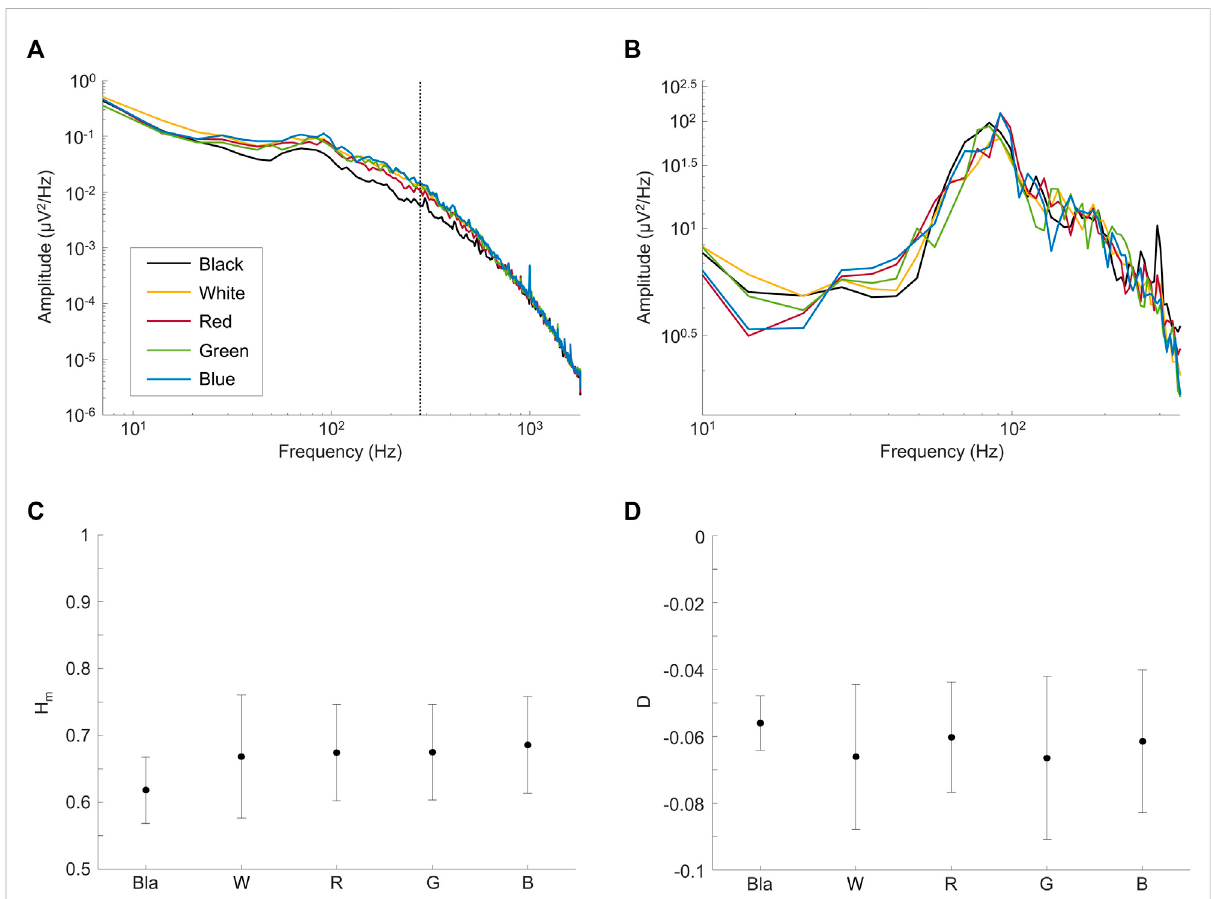
FIGURE 3 Comparing rsERGs at background light colors. Mean frequency spectrums of rsERGs obtained from different colored background lights at 30 cd m − 2 , i.e., black (no illumination; black tracings), white (yellow tracings), red (red tracings), green (green tracings) and blue (blue tracings). (A) Original mean frequency spectrums in log-log scale. Of note, the vertical dotted line shows the upper limit of data points used in the linear regression, i.e., data points from 7 Hz to 275 Hz. (B) Modi fi ed spectrums (zoomed) in log-log scale, with the 1/ f α background activity removed. (C,D) Multifractal analysis on the colored rsERG signals. (C) Values ± STD of the main exponent H m . (D) Values ± STD of the dispersion index D